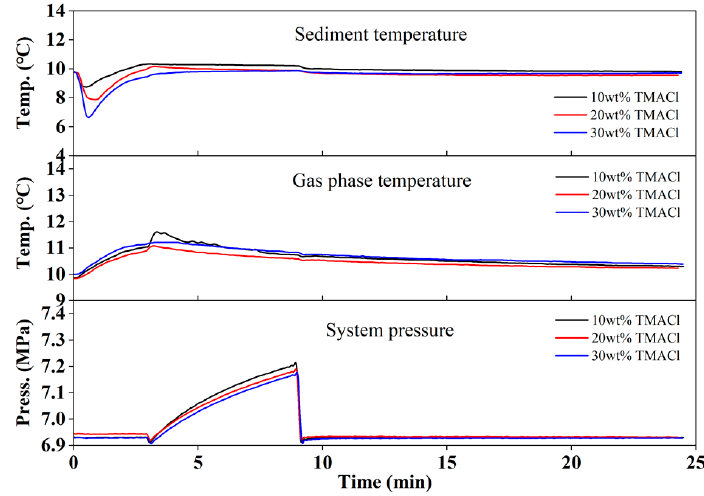
Figure 10. E ff ect of TMACl concentration on gas production.